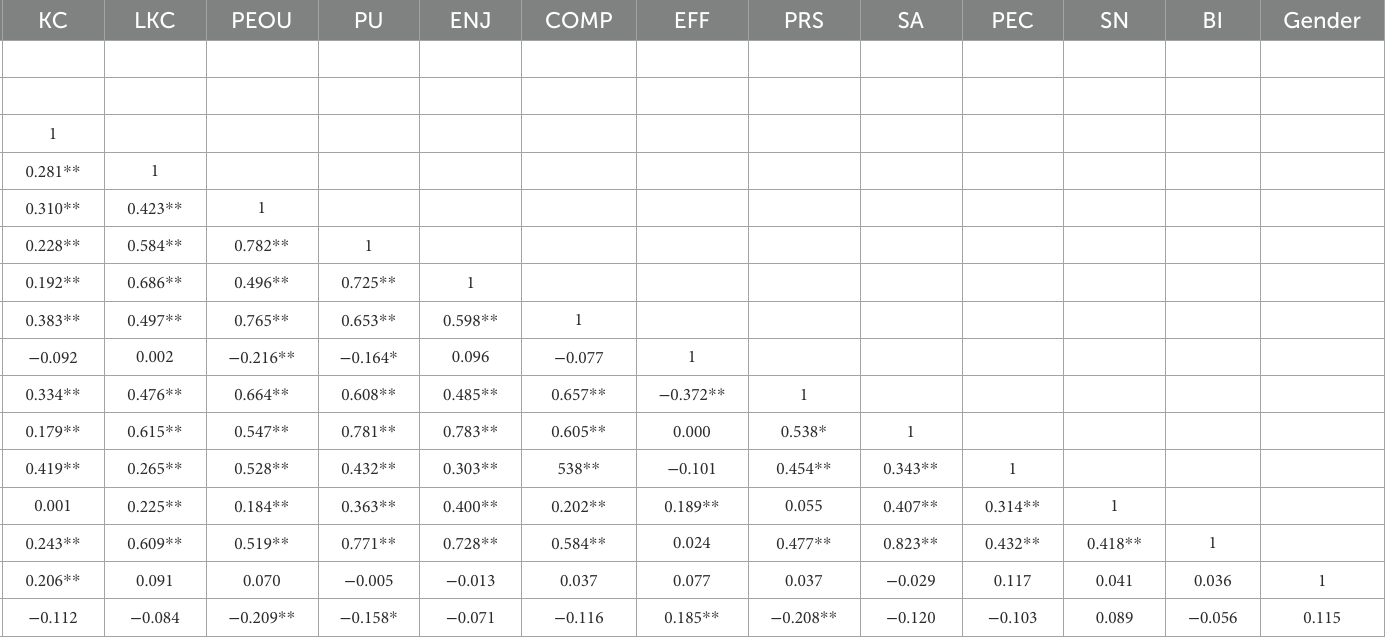
TABLE 5 Correlation